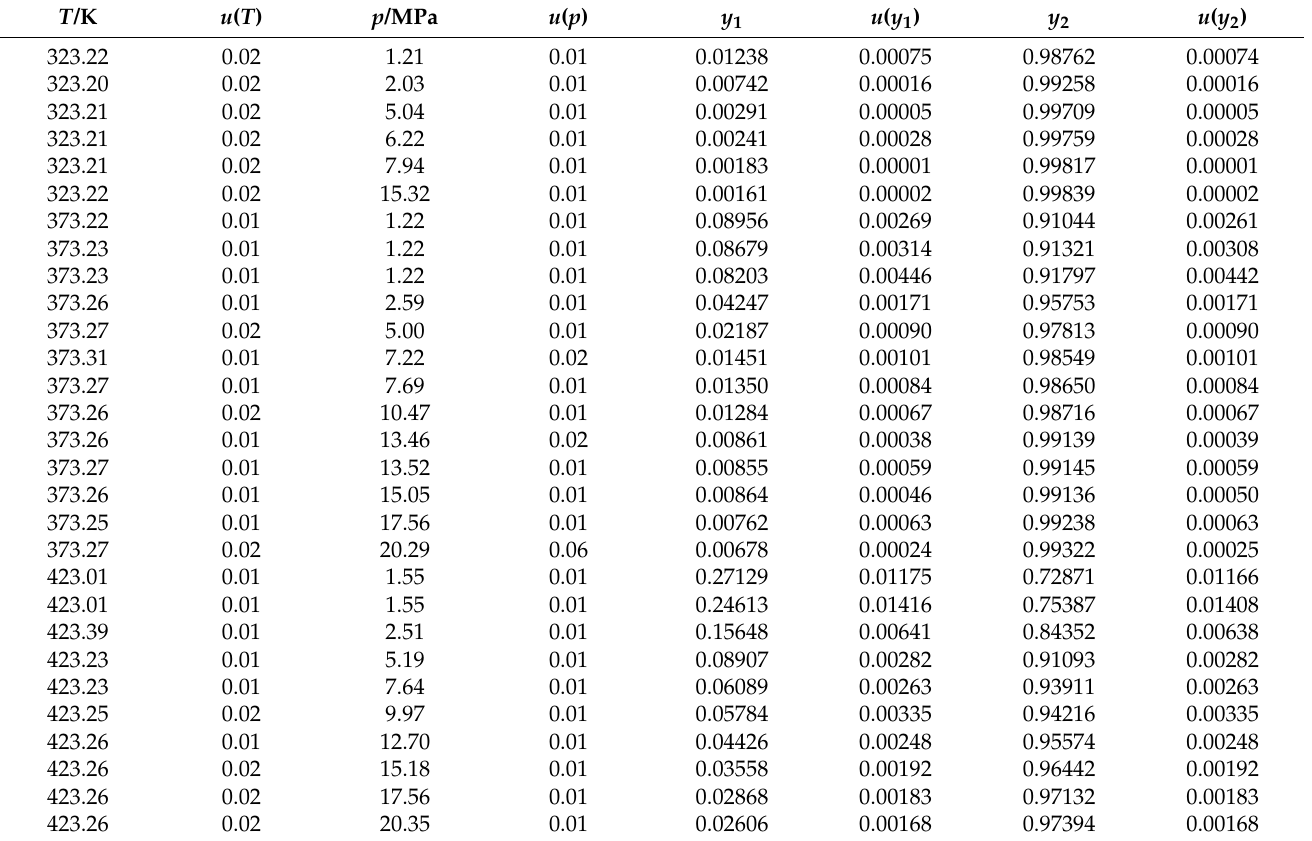
Table 8. Experimental vapour-phase data for the H 2 O(1) + N 2 (2) system at different temperatures, T , and pressures p . y and u denote the mole fraction of water in the vapour phase and standard uncertainty,